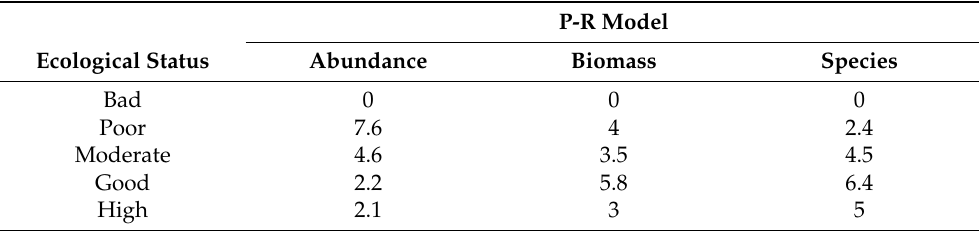
Figure 3. Correlations between ISEP grades and environmental factors along the west coast of Korea. Table 2. Unitless value of SAB estimated from P-R model to use as a reference to validate the ISEP